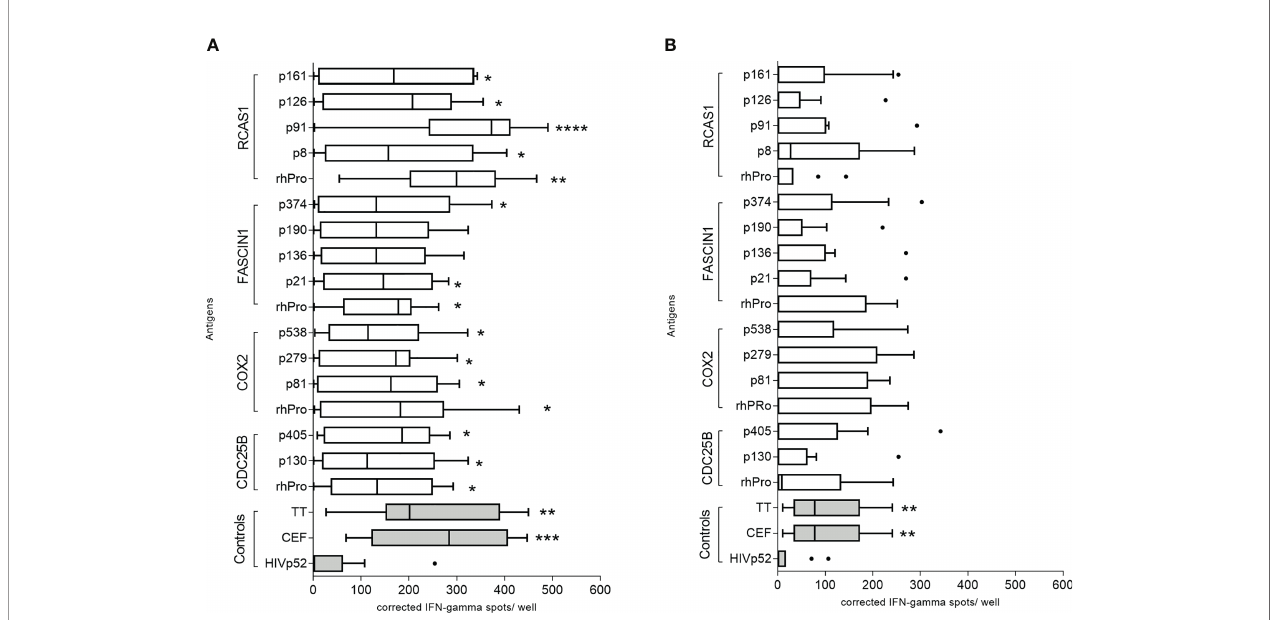
FIGURE 2 | IFN- g -secreting cells speci fi c for both peptide and protein antigens can be identi fi ed in the peripheral blood of colorectal cancer patients. Corrected spots per well for (A) colorectal cancer patient or (B) volunteer donor PBMC stimulated with recombinant protein and individual peptides, presented as a box and whisker plots, horizontal line at median and Tukey outliers ( fi lled circles). Negative control: HIVp52-66 and positive controls: pool of overlapping viral epitopes (CEF) and tetanus toxoid (TT). rhPro: recombinant human protein for that antigen set. *p < 0.05, ***p < 0.001, ****p < 0.0001 compared to the negative control. n = 10 colorectal cancer patients and 10 volunteer donors.